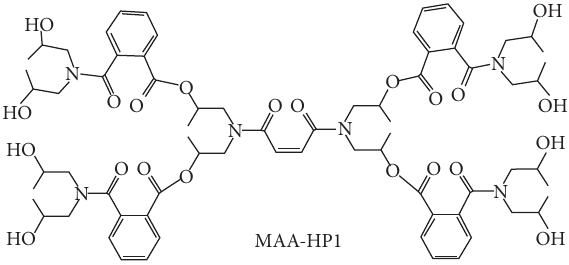
Figure 5: Molecular structure of hyperbranched PCE (terminal hydroxyl type).